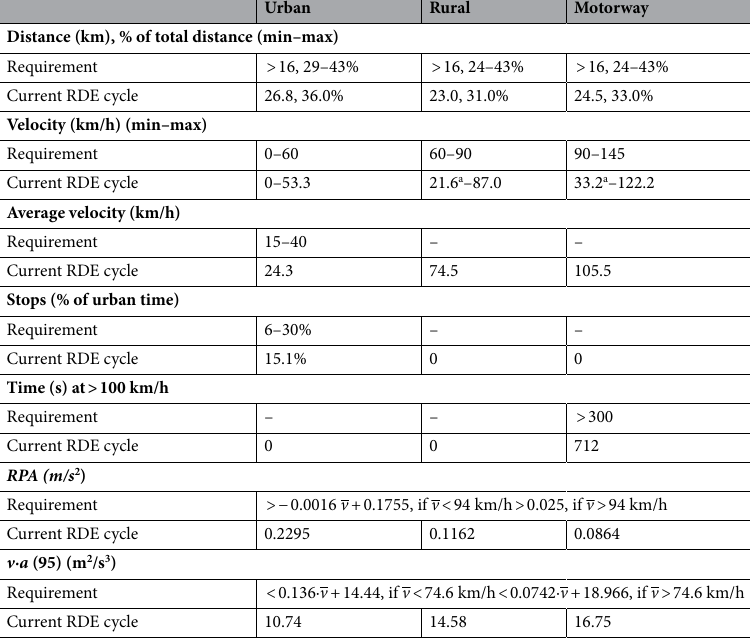
Table 4. Required specifications for RDE cycle and description of current RDE cycle. a Values below the required limit in each phase correspond to a few instants for access to roads and roundabouts.